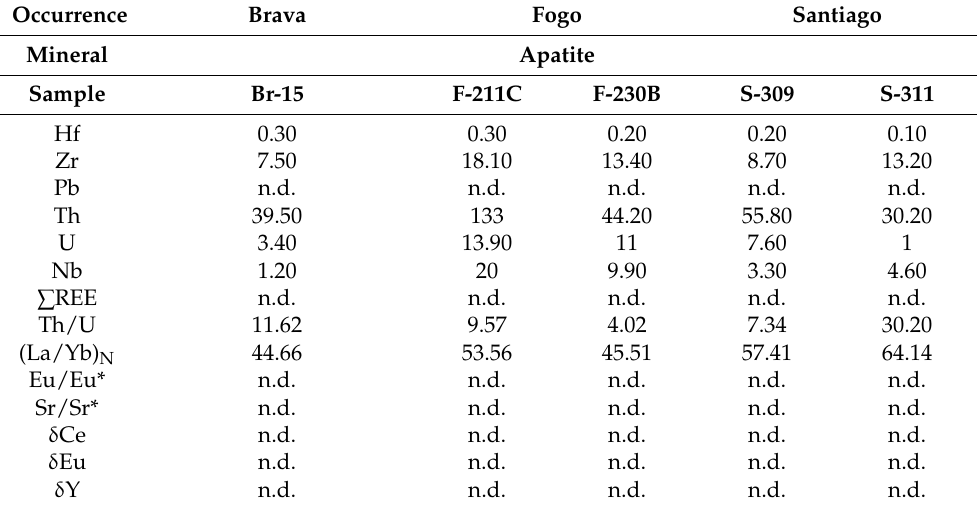
Table A2. Cont. Occurrence Brava